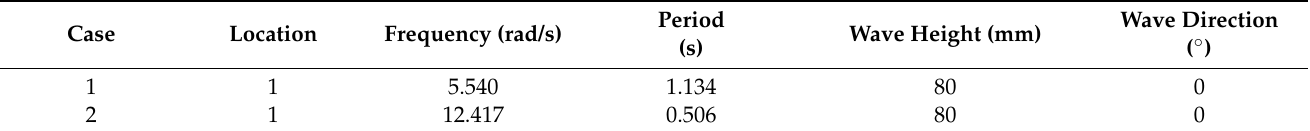
Figure 7. Frequency results of point 1 with wave direction 0°, 30° and −30°.